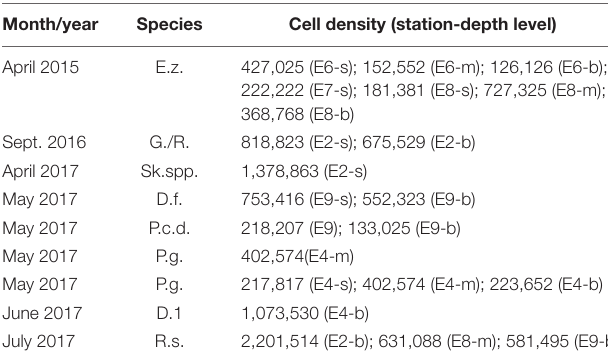
TABLE 2 | Algal bloom recorded on April 2015, and several months of 2016 and 2017 in the surface (s), mid-depth (m), and bottom (b) by sampling station and depth level.